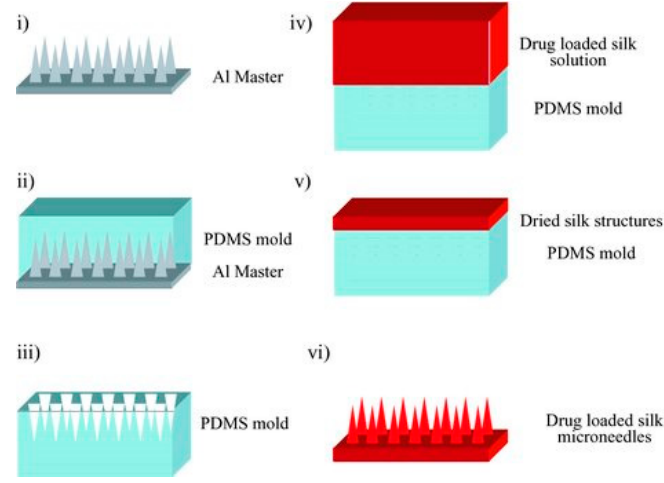
Figure 4. Schematic of silk microneedle fabrication for drug delivery. (Reproduced with permission from Reference [78], John Wiley and Sons).